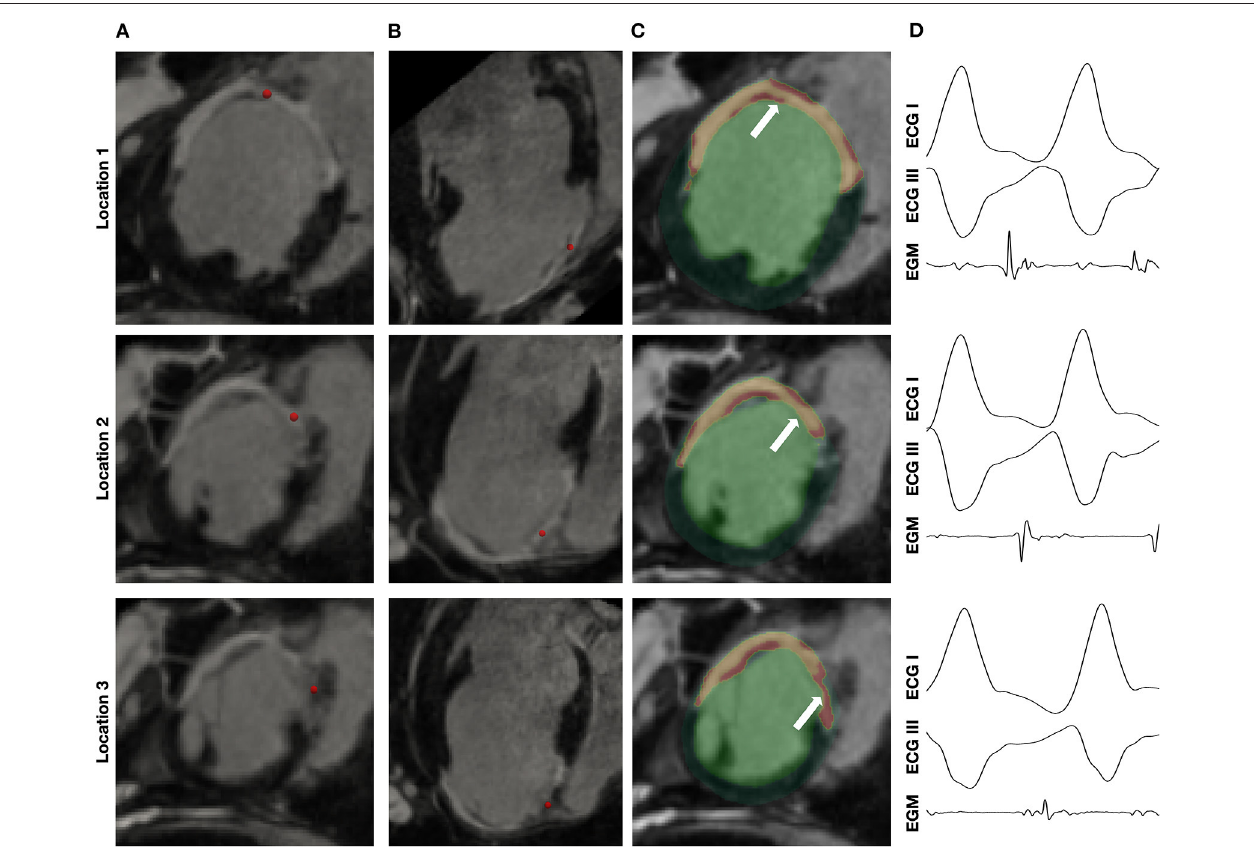
FIGURE 2 | Visualization of location of diastolic EGMs on in-vivo CMR. Column (A) and column (B) show short axis (SAX) and long axis (LAX) multiplanar reconstruction (MPR) of in-vivo CMR with the location of the corresponding diastolic EGM [column (D) ] indicated by a red sphere. Column (C) shows SAX MPR of in-vivo CMR with segmentation of scar (yellow) and heterogeneous tissue (HT) (red) superimposed. 89% lay within 10 mm of HT. These results are illustrated in Figure